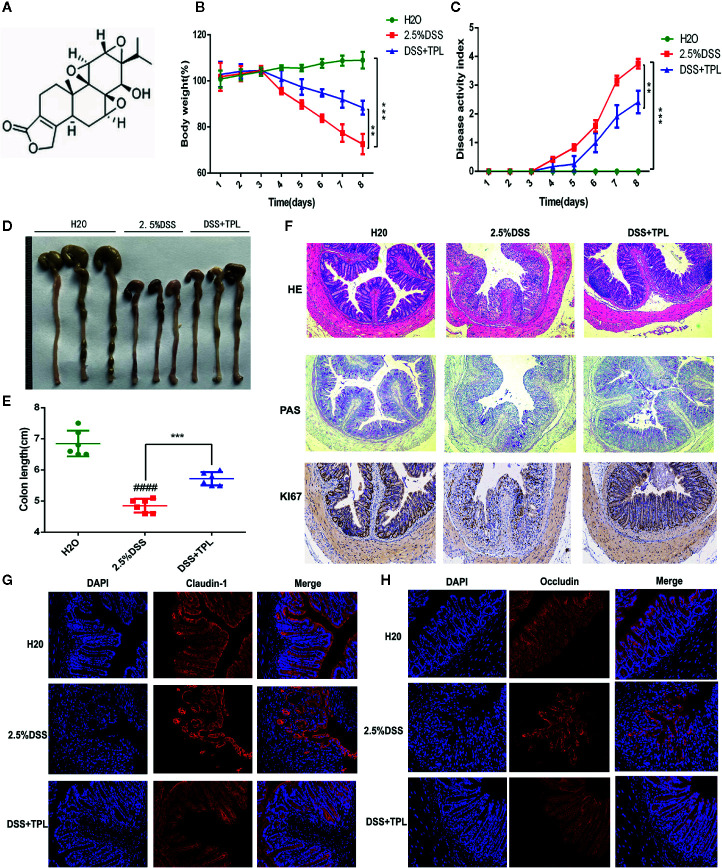
The protective effect of triptolide on DSS-induced colitis mice. (A) The chemical structure of triptolide is shown. Mice aged 6–8 weeks were treated with 2.5% DSS with or without triptolide administration. (B) The body weight and (C) disease activity index (DAI) of these mice during the experimental period are depicted. (D–F) The pathological features of colitis are depicted by HE staining, PAS staining, and immunohistochemical assay of Ki67 levels. The expression of (G) claudin-1 and (H) occludin are indicated by immunofluorescence assay. Data are shown as the mean ± SD of at least three independent experiments. **P < 0.01; ***P < 0.001. #### means that the statistical difference between the results of the 2.5% DSS group and the H2O group was P < 0.0001.